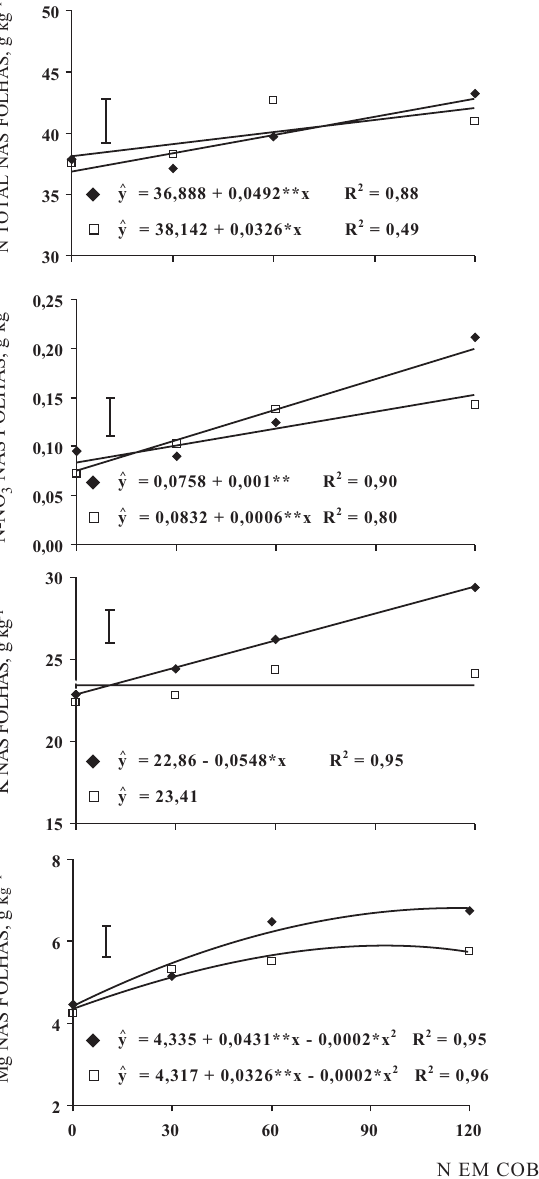
+ , N-NO - , fósforo, potássio, cálcio, magnésio e enxofre nas folhas do feijoeiro Figura 2. Teores de N total, N-NH 4 3 em função de doses de nitrogênio aplicadas em cobertura, utilizando como fonte nitrocálcio ( ) ou uréia ( ). * e **: significativos a 5 e 1 % pelo teste t, respectivamente. Barras verticais indicam o valor de DMS a 5